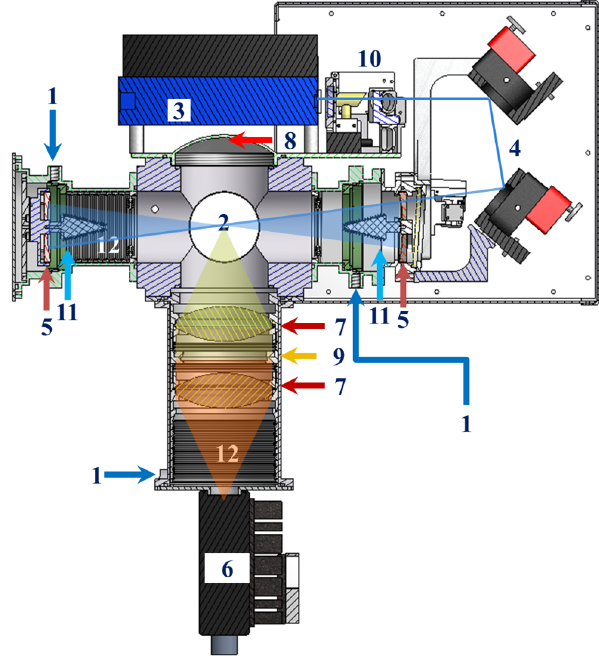
Figure 1. Section view of GANDALF (section view is based on Inventor 2009. The figure is created by defining a plane used to cut through the whole assembly. 3-D AutoCAD models (1) for the diode laser by courtesy of Omicron Laserage Laserprodukte GmbH and (2) for optical mirror holders by courtesy of Newport). (1) Flushing for optics. (2) Detection area. (3) Diode laser. (4) Mo- torized mirrors; (5) Herriott cell’s mirrors. (6) PMT. (7) Focusing lens. (8) Concave mirror. (9) Interference/optical filters. (10) Opti- cal reference system. (11) and (12)